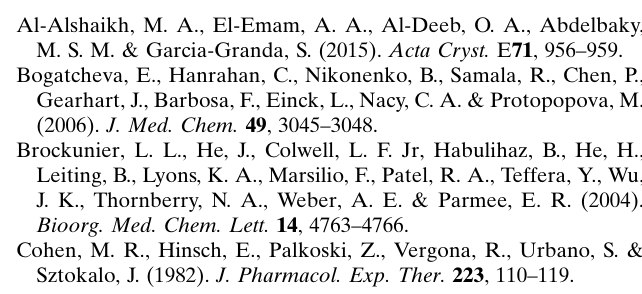
Crystal data Chemical